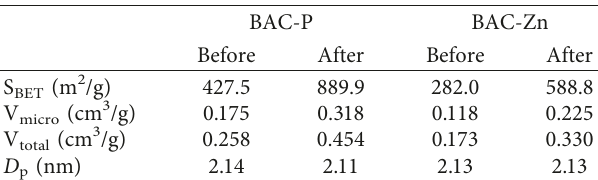
Table 2: BETsurface area, pore volume, and average pore diameter of BAC-P and BAC-Zn adsorbents. BAC-P BAC-Zn Before After Before